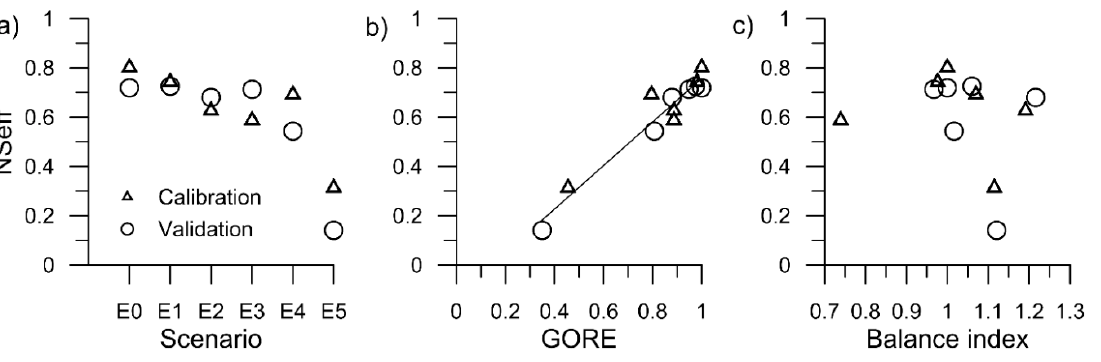
Figure 5. Impact of rainfall quality on model performance (NSeff) against: ( a ) rainfall monitoring scenario, ( b ) GORE index, and ( c ) Balance Index. For calibration and validation period.